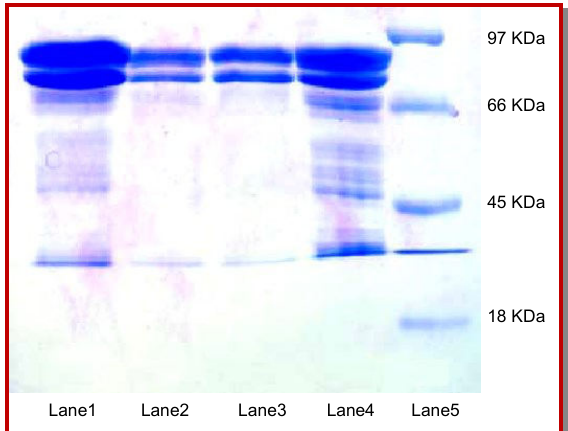
Figure 1: SDS-PAGE profile (Lane 1: Male hemocytes; Lane 2: Male plasma; Lane 3: Female plasma; Lane 4: Female hemo- cytes; Lane 5: Protein marker)